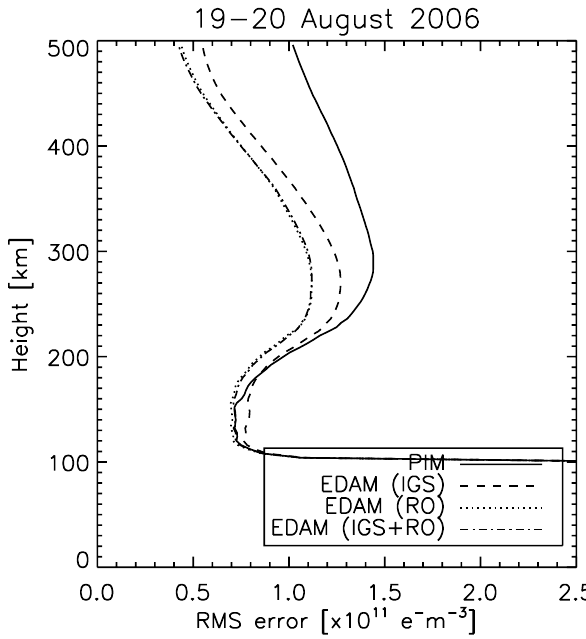
Fig. 9. RMS error between ionospheric models and Abel transform vertical profiles at 5km height steps on 4 September 2006 (mod- erate geomagnetic conditions). The models are: PIM (solid line); EDAM assimilating IGS data only (dashed line); EDAM assimilat- ing COSMIC RO data only (dotted line); and EDAM assimilating IGS and COSMIC RO data (dot-dash line).